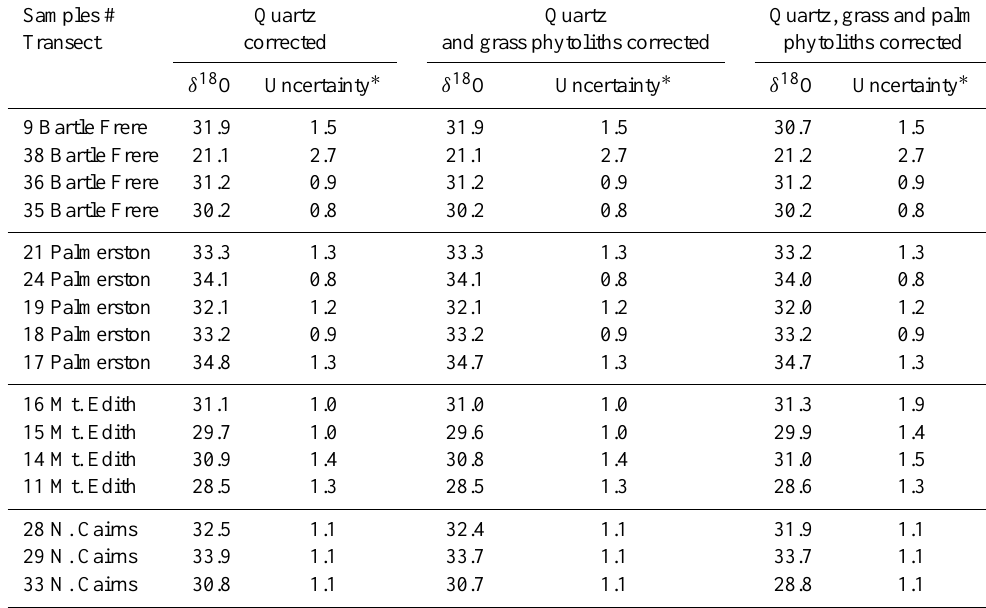
Table 3. δ 18 O wood phytolith values obtained after weight correction for the presence of quartz particles, grass and palm phytoliths. Samples # Quartz Quartz Quartz, grass and palm Transect corrected and grass phytoliths corrected phytoliths corrected δ 18 O Uncertainty ∗ δ 18 O Uncertainty ∗ δ 18 O Uncertainty